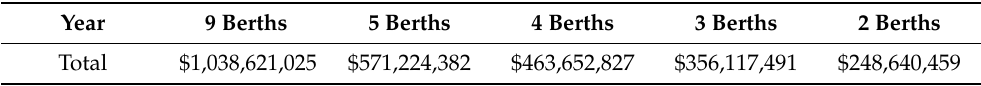
Table 14. Estimated interest costs from 2020 to 2049 (units: U.S.